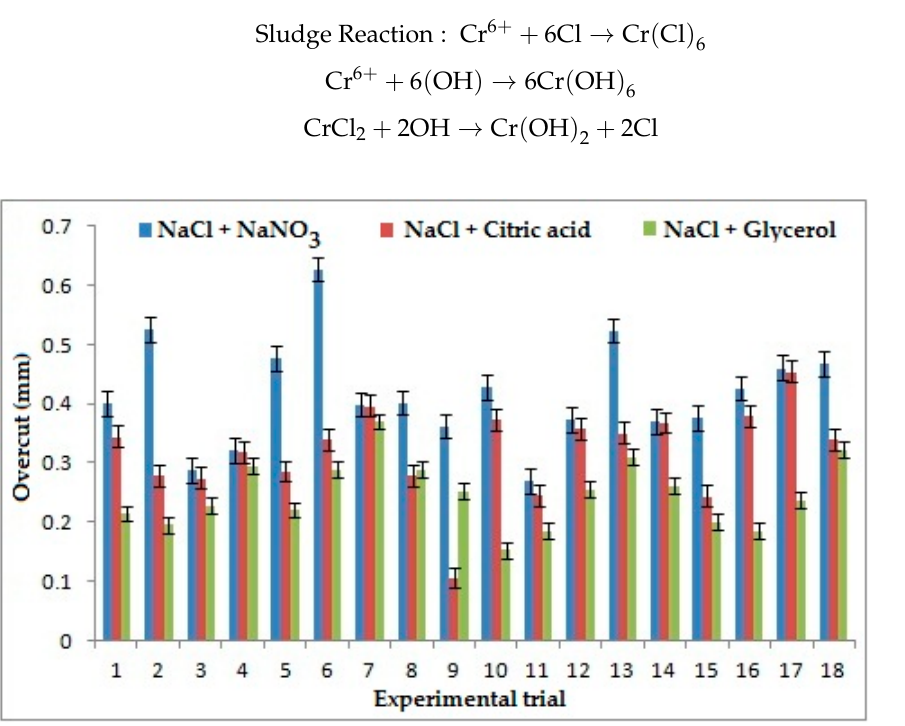
Figure 4. Effects of electrolytes and process parameters on overcut .